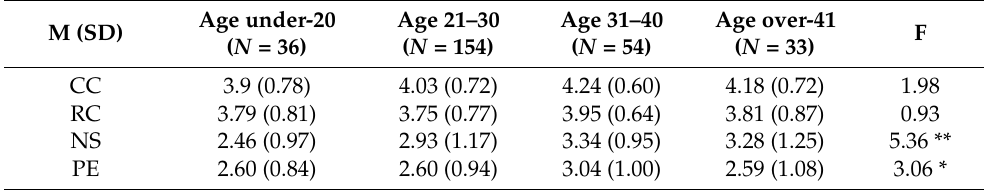
Table 11. Differences of take-over intention among age